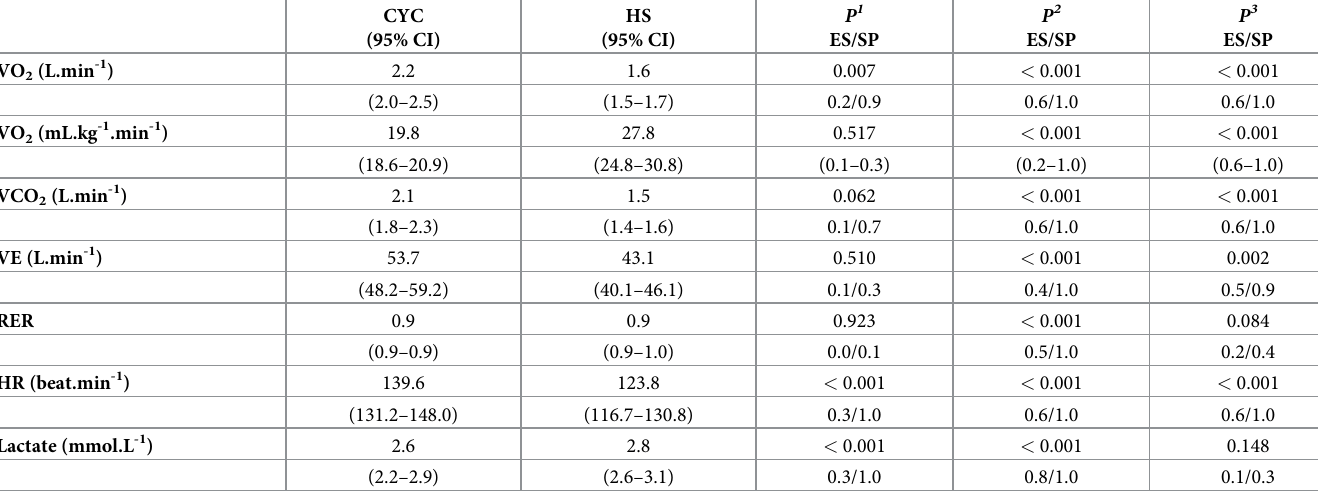
Table 2. Differences in cardioventilatory and lactate responses between half-squat vs cycle-ergometer during constant-load test at lactate threshold